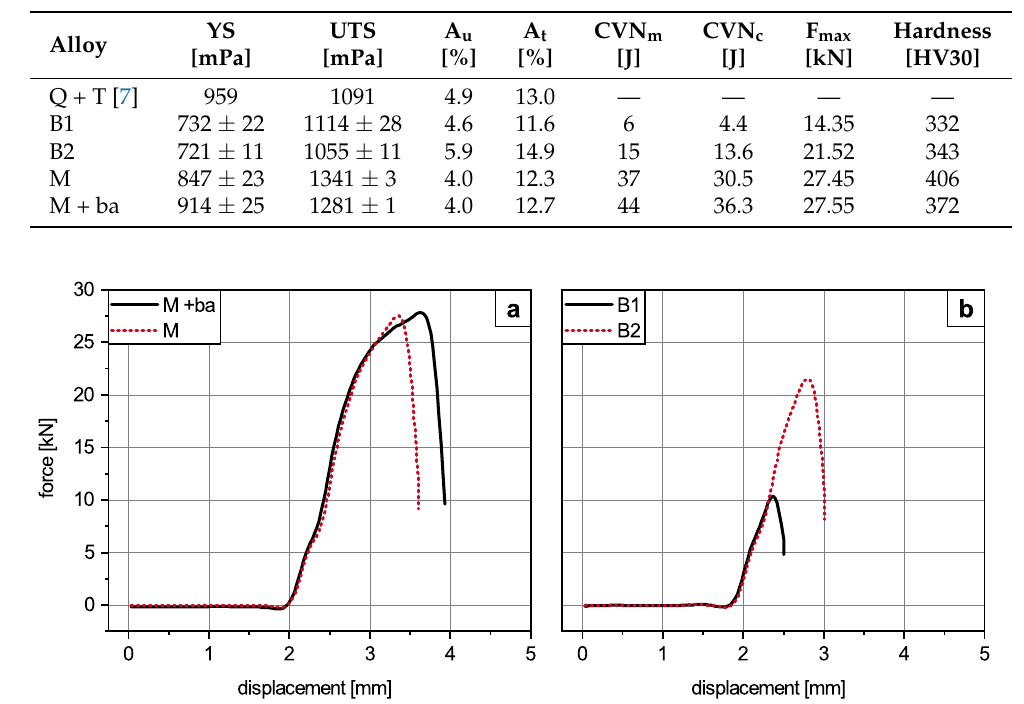
Figure 12. Force–displacement curves of the investigated materials obtained by instrumented Charpy V-notch impact test. The curves of the martensitic steel for both conditions are shown in ( a ), while the bainitic steels are displayed in ( b